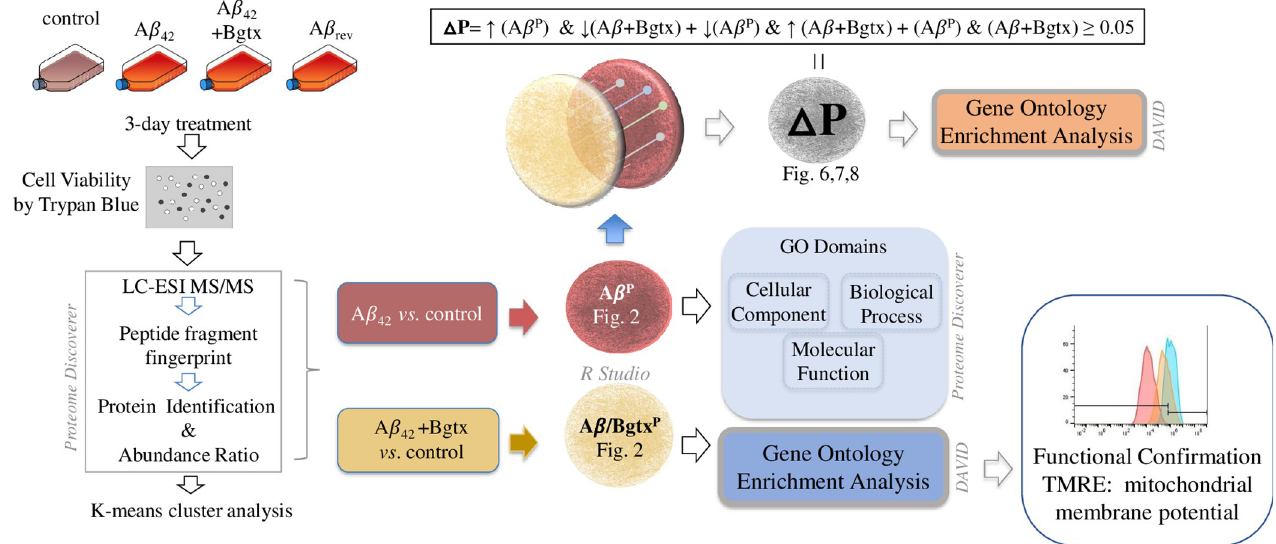
Fig 1. A summary of the experimental design and analyses. A workflow schematic showing the treatment conditions and briefly describing the mass spectrometry and bioinformatic analyses performed.